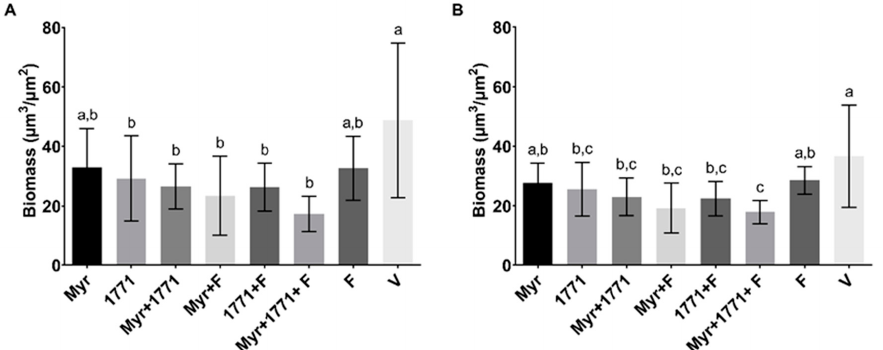
Figure 8. Biovolume of bacteria and EPS in topically treated biofilms. Biovolume is represented as biomass (µm 3 /µm 2 ) of bacteria ( A ) and EPS ( B ). Bars with the same letters indicate no statistical difference between the different treatments in each graph ( p > 0.05; one-way ANOVA, followed by Tukey’s test). The data represented are the means, and the error bars correspond to the standard deviation.